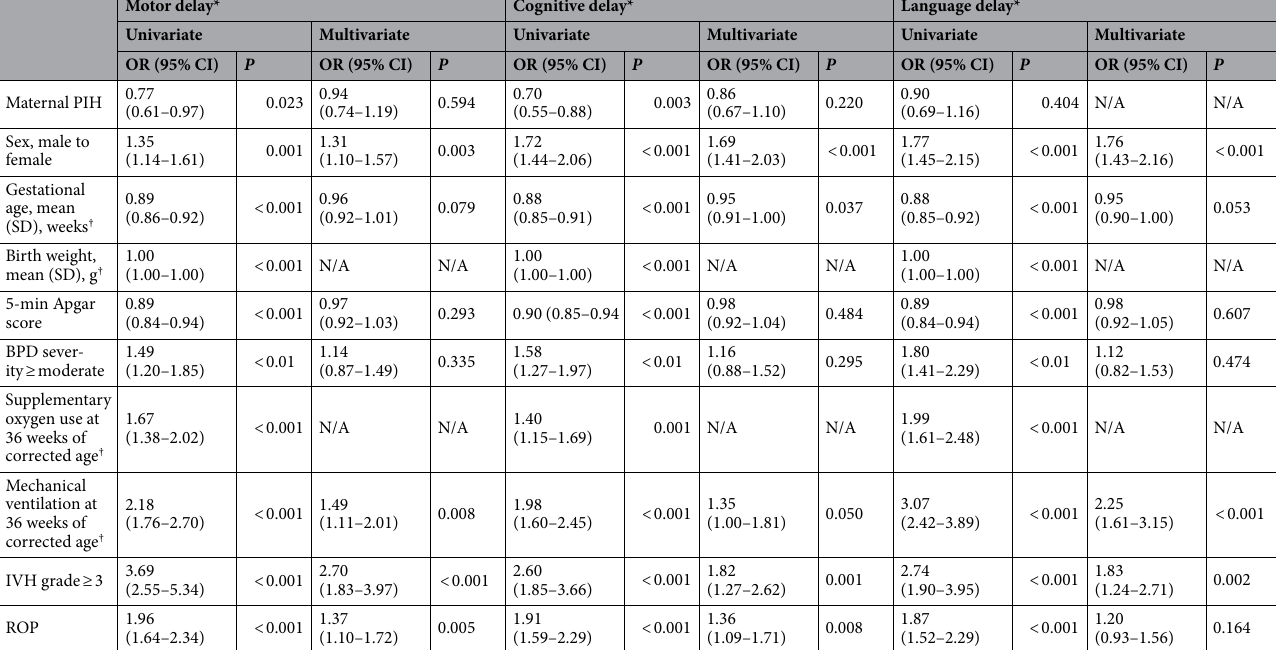
Table 3. Clinical factors associated with developmental delay in univariate and multivariate regression analyses. OR odds ratio, CI confidence interval, ROP retinopathy of prematurity, PIH pregnancy-induced hypertension, PROM premature rupture of membranes, GDM gestational diabetes mellitus, RDS respiratory distress syndrome, BPD bronchopulmonary dysplasia, NEC necrotizing enterocolitis, IVH intraventricular applicable. *Motor delay is represented by a PDI score of < 85 on BSID-II subsets, a motor score of < 85 on BSID-III subsets, or a motor score of < − 1 SD on K-DST subsets. Cognitive delay is represented by an MDI score of < 85 on BSID II subsets, a cognitive score of < 85 on BSID-III subsets or < − 1 SD on K-DST subsets. Language delay is represented by a language score of < 85 on BSID-III subsets or < − 1 SD on K-DST subsets. † The variables with significant correlation were not analyzed simultaneously to avoid multicollinearity (birth weights and mechanical ventilation at 36 weeks of were not used due to significant correlation with gestational age and supplementary oxygen use at the time).